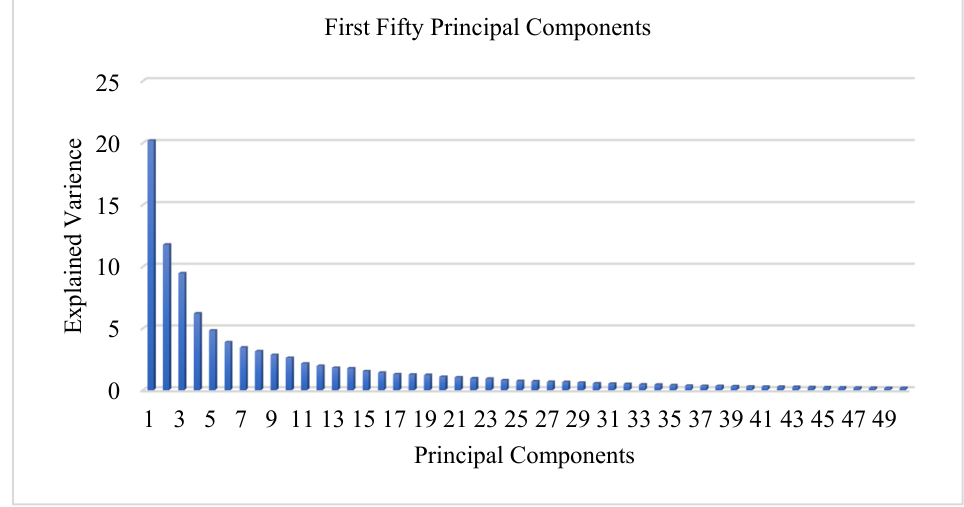
Figure 6. Variance Explained by First Fifty PCs.